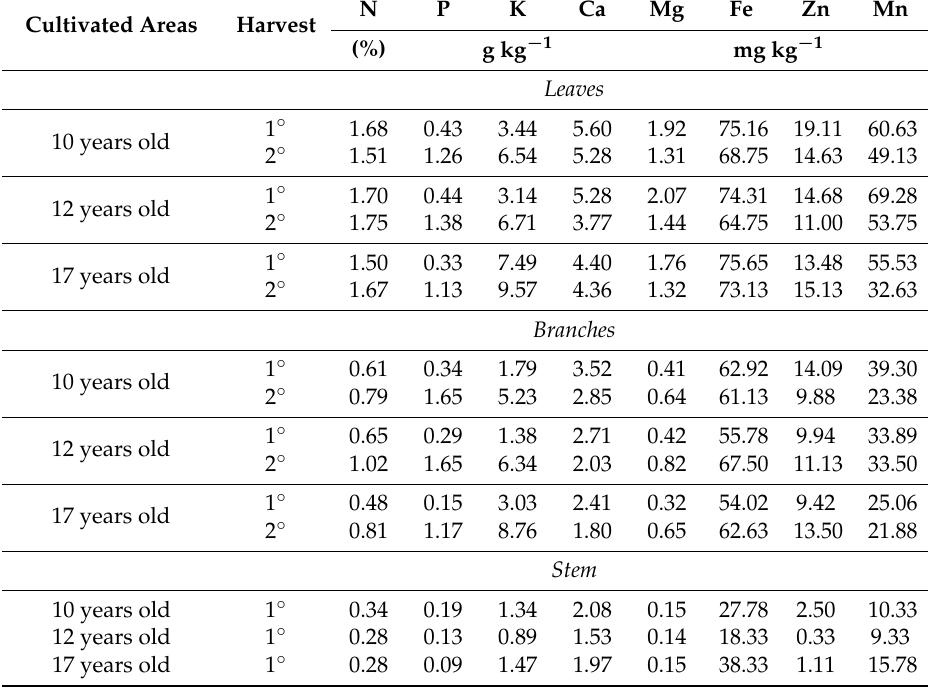
Table 1. Chemical attributes of trunks, branches and leaves collected from Rosewood plantations in Mau é s and Novo Aripuan ã regions at first harvest (reference-harvest = 1st) and at second harvest (regrowth material-harvest =